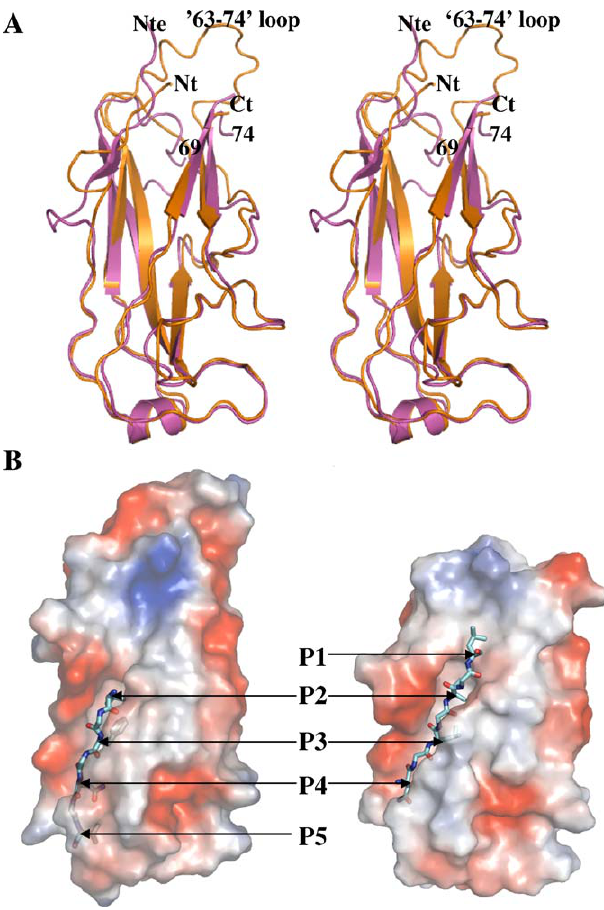
Figure 3. Comparison of dsePapA and dscPapA in the PapD/ (PapA